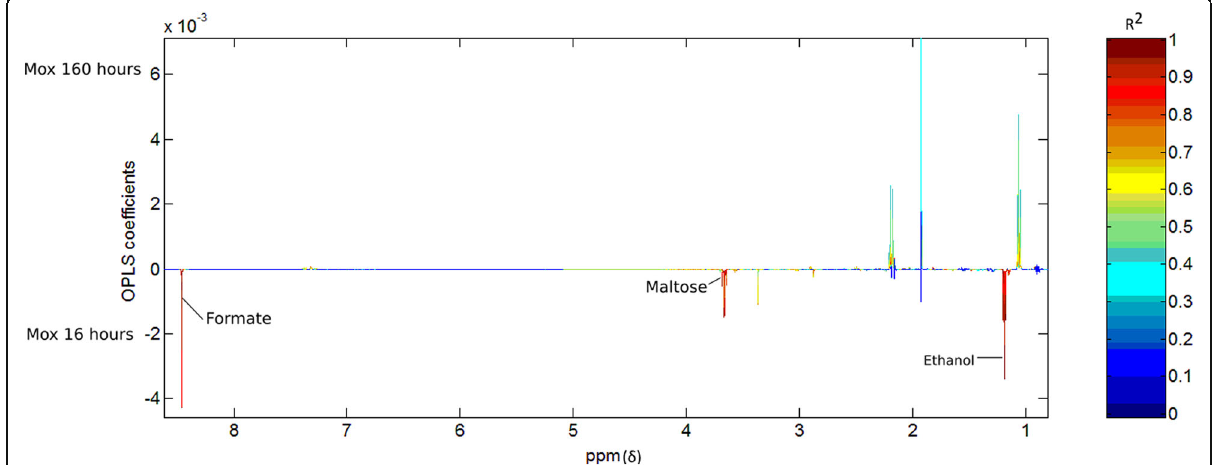
Fig. 5 Correlation coefficient plot from the OPLS-DA model built with data from the fermentation inoculums of faeces collected at 16 h and 160 h from the horses treated with moxidectin ( R 2 = 0.79, Q 2 Y = 0.77)